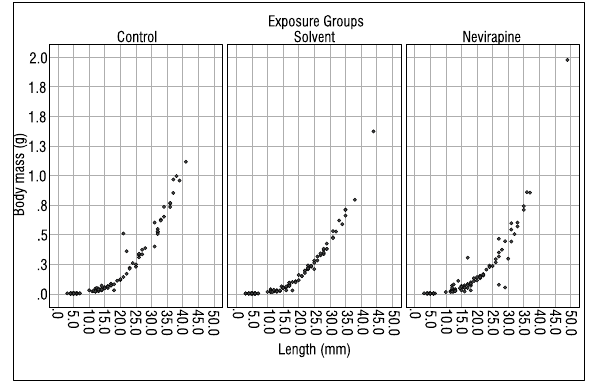
Figure 1: Survival rate of juvenile fish from the three exposure groups on Day 60 post-hatching.